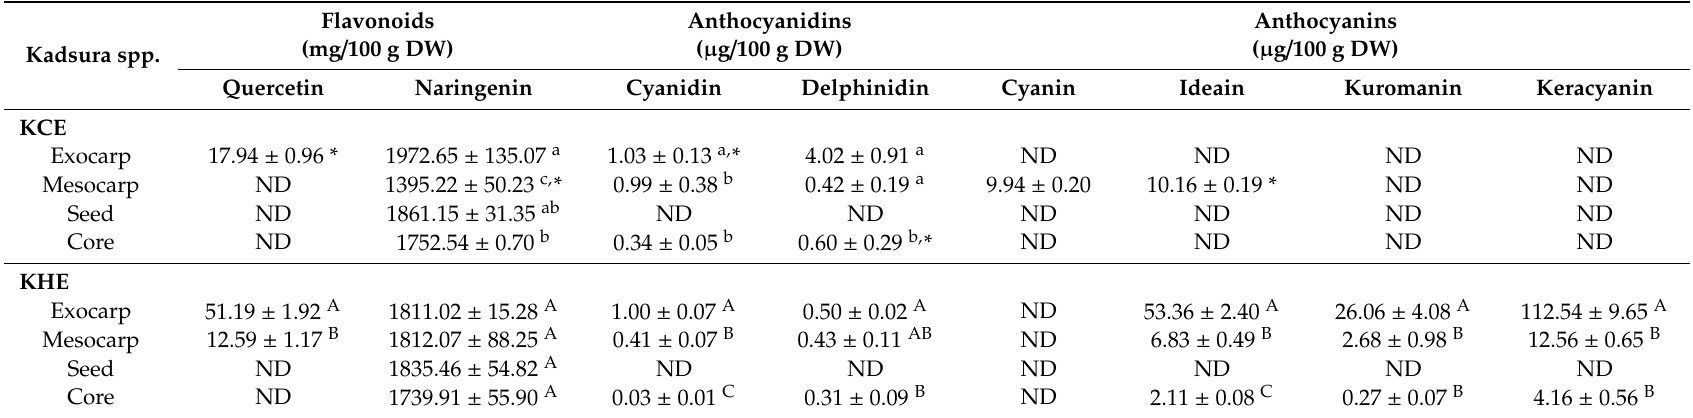
Table 4. Phenolic profiles in di ff erent fruit parts of Kadsura coccinea (Lem.) A.C. Sm. extract (KCE) and Kadsura heteroclita (Roxb.) Craib extract (KHE).